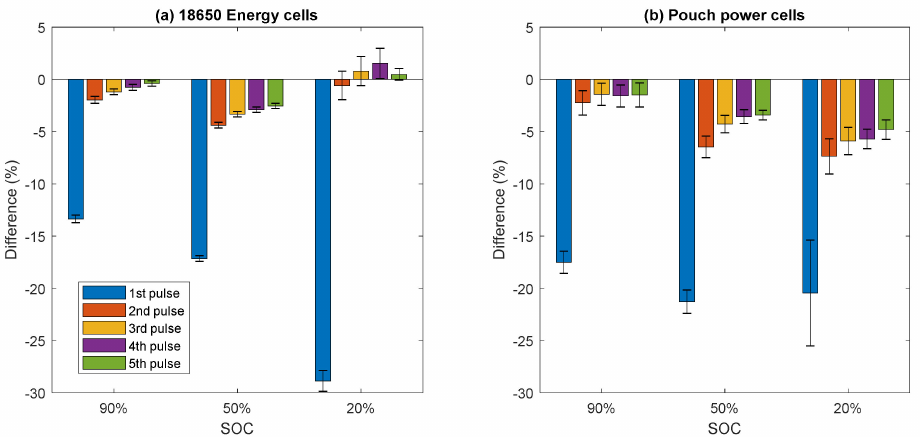
Figure 7. Individual pulse internal resistance measurements difference (accelerated minus